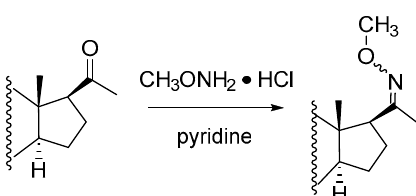
Scheme 1. Example for derivatization of keto groups with O -methylhydroxylamine hydrochloride in Molecules 2019 , 24 pyridine [20].